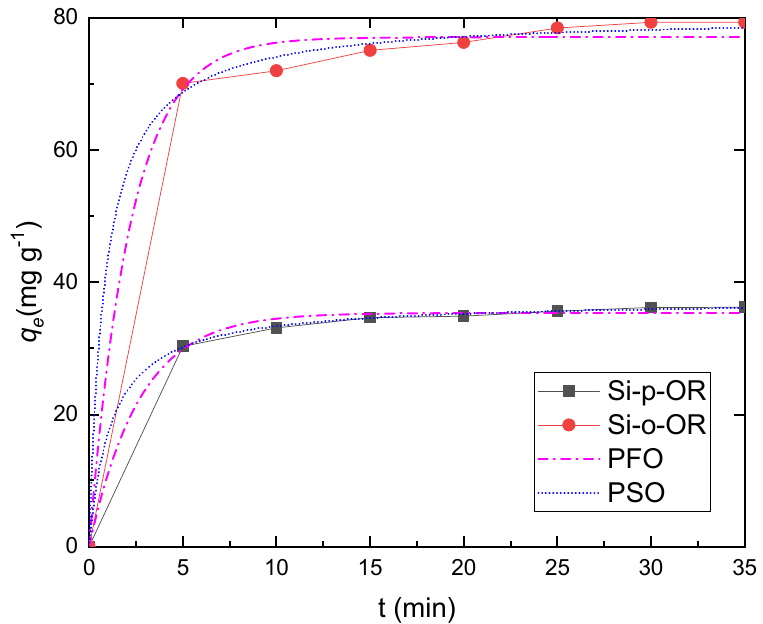
Figure 7. Adsorption of Cu(II) by Si-o-OR and Si-p-OR with time, fitted by a pseudo-second- order model. Adsorption conditions: V = 10 mL, m = 10 mg of adsorbent, pH = 6, and optimum concentration = 120 mg L − 1 at 25 °C.